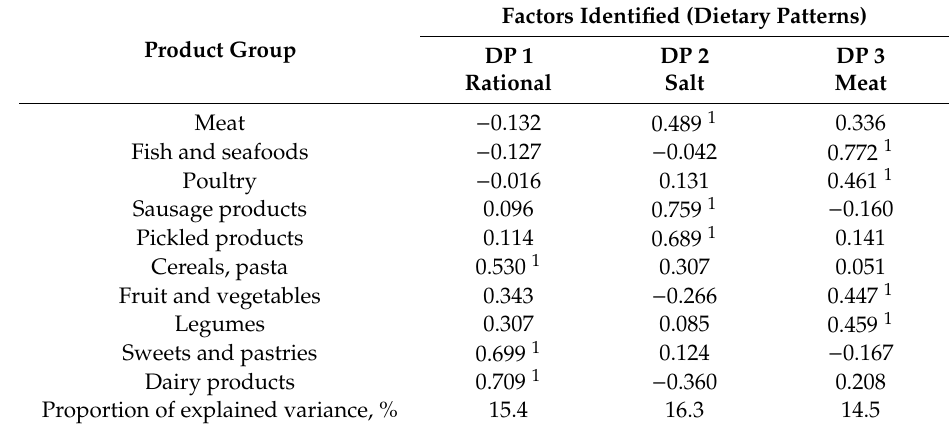
Table A15. Factor loadings of the principal dietary patterns identified (St. Petersburg).